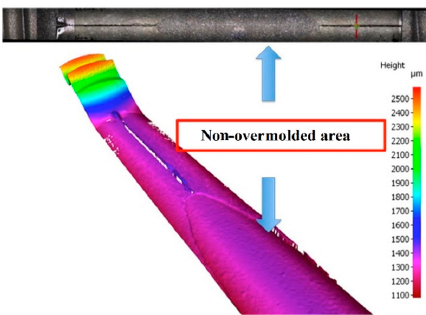
Figure 10. Picture ( top ) and surface scan ( bottom ) of the non-overmolded area due to bending of the metal screw.